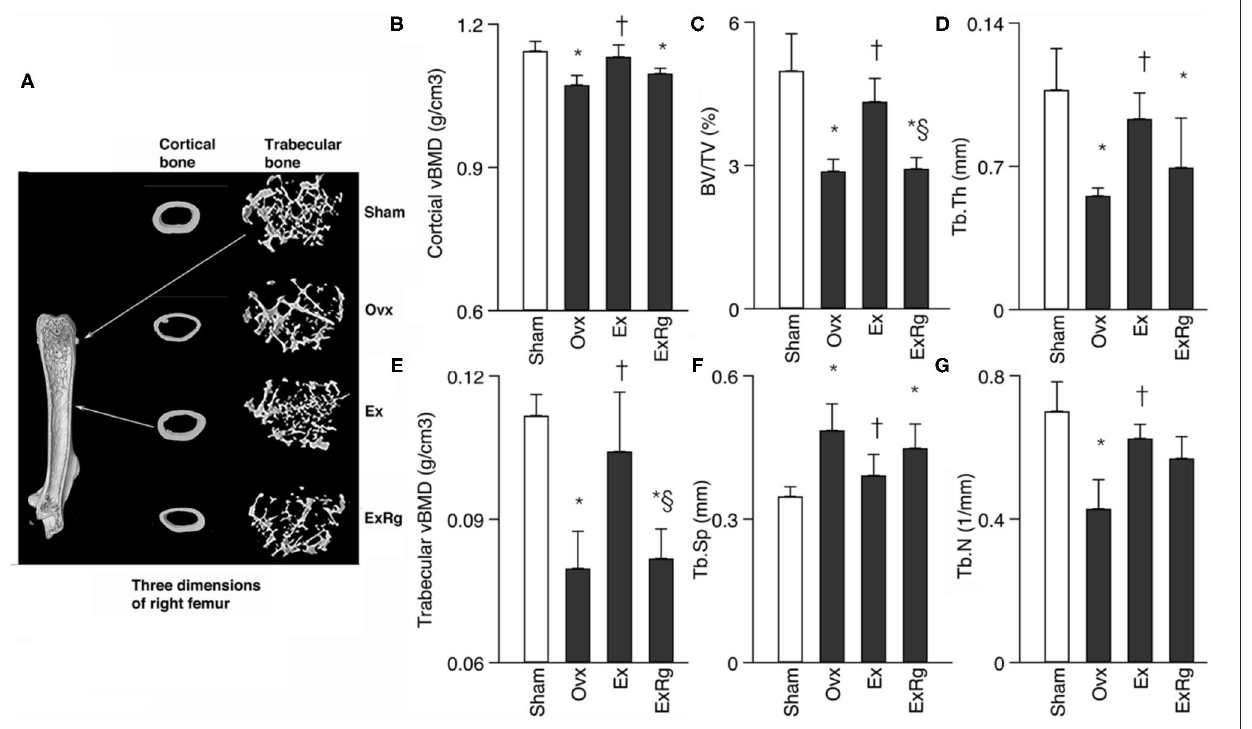
FIGURE 1 | Comparisons between groups for cortical and trabecular volumetric bone mineral density (vBMD) and trabecular bone volume fraction (BV/TV), thickness (Tb.Th), numbers (Tb.N) and separation (Tb.Sp). Micro-CT analysis was performed for sham, ovariectomized (Ovx), Ovx plus exercise (Ex), and Ovx plus exercise and cRGDyk (ExRg) groups (each group, n = 10). Data are presented as mean ± SD. (A) Three dimensions of right femur; (B) cortical vBMD (g/cm 3 ); (C) BV/TV (%); (D) Tb.Th (mm); (E) trabecular vBMD (g/cm 3 ); (F) Tb.Sp (mm); (G) Tb.N (1/mm). *Denotes the difference between Sham group and Ovx, Ex, and ExRg groups was significant ( p < 0.05); † indicates the difference between Ovx group and Ex and ExRg groups was significant ( p < 0.05); § presents the difference between Ex group and ExRg group was significant ( p <